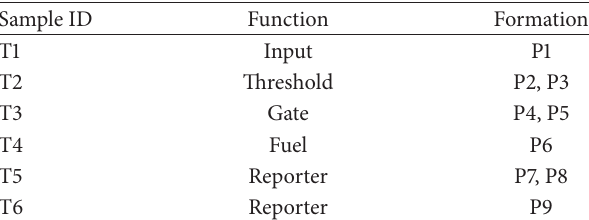
Table 3: Domains of the DNA